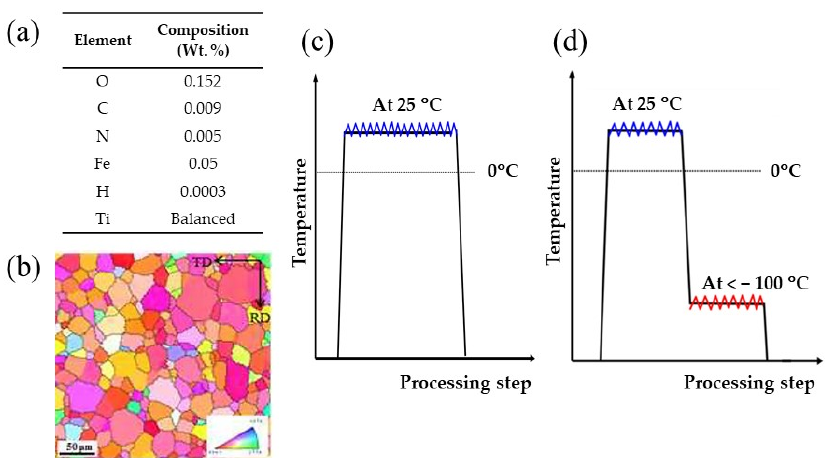
Figure A1. ( a ) Chemical composition of the material used. ( b ) Initial microstructure of CP-Ti Gr.2 before the rolling. ( c , d ) shows the rolling history of cold rolling and cryogenic rolling; total reduction in area was about 78% in both.